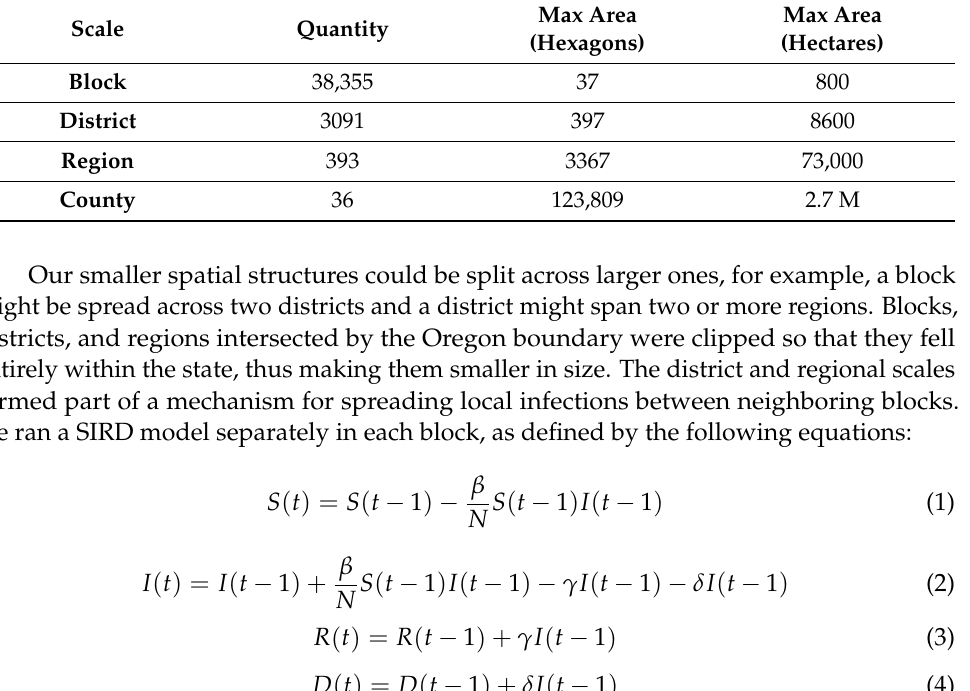
Table 1. Four spatial scales used in the HexSim COVID simulations. Scale Quantity Block 38,355 37 800 District 3091 397 8600 Region